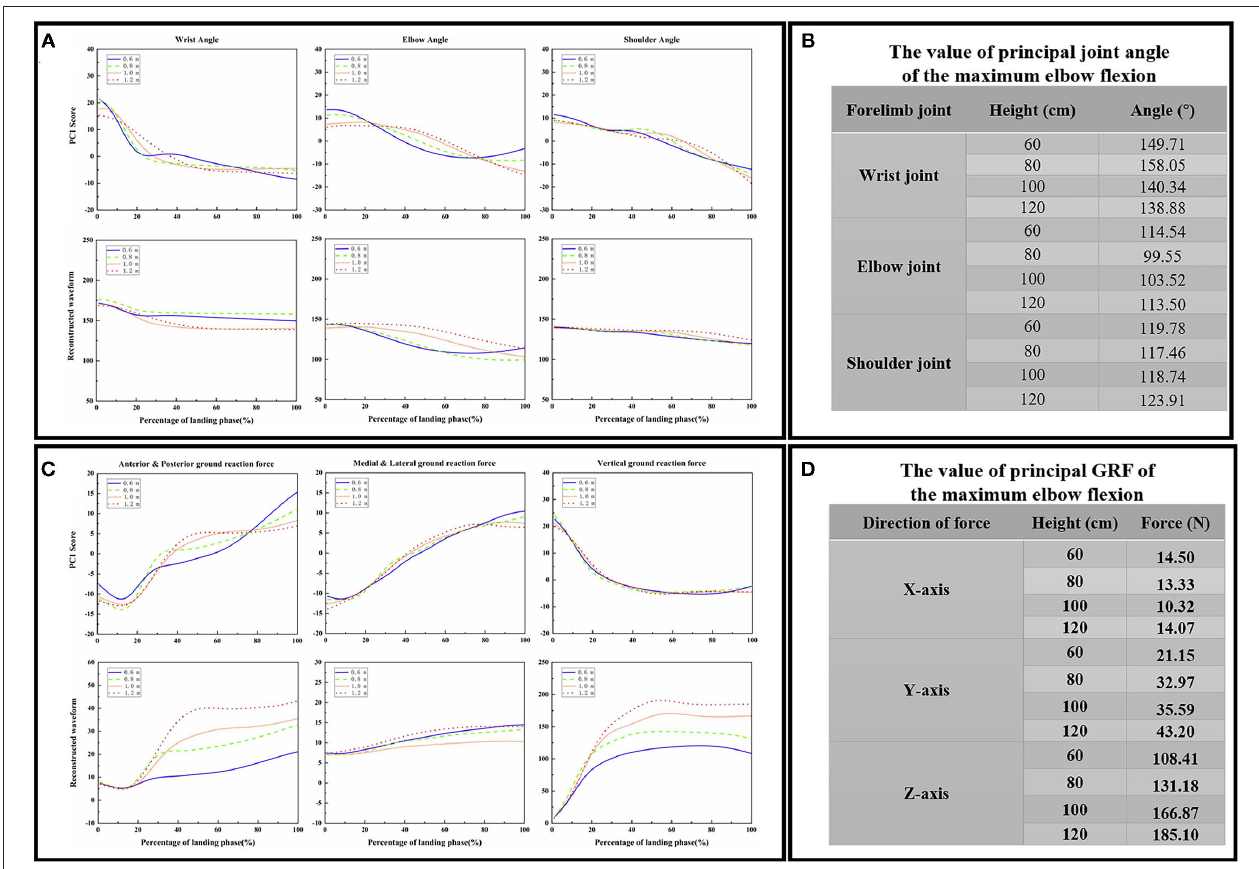
FIGURE 4 | (A) The first PC scores PC 1 for each landing height and each joint sagittal angle (wrist joint, elbow joint, and shoulder joint), the reconstructed waveform (principal joint angle) based on the first PC scores PC 1 . (B) The value of the principal joint angle of the maximum wrist flexion data point in each joint during landing from different heights. (C) The first PC scores PC 1 for each landing height and each direction GRF (anterior and posterior, medial and lateral, and vertical), the reconstructed waveform (principal GRF) based on the first PC scores PC 1 . (D) The value of principal GRF of the maximum wrist flexion data point in each direction during landing from different heights.